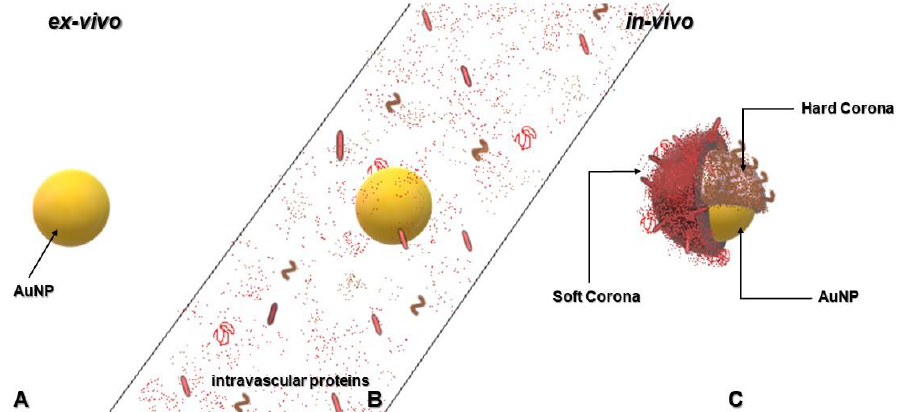
Figure 2. Formation of protein corona in blood plasma when NPs are injected into the blood circulation system during therapy. ( A) . AuNPs in their original form before administration ( B ). AuNPs in the vascular system exposed to intravascular proteins ( C ). AuNPs coated with proteins and protein fragments, which renders the AuNP unrecognizable at the target site.